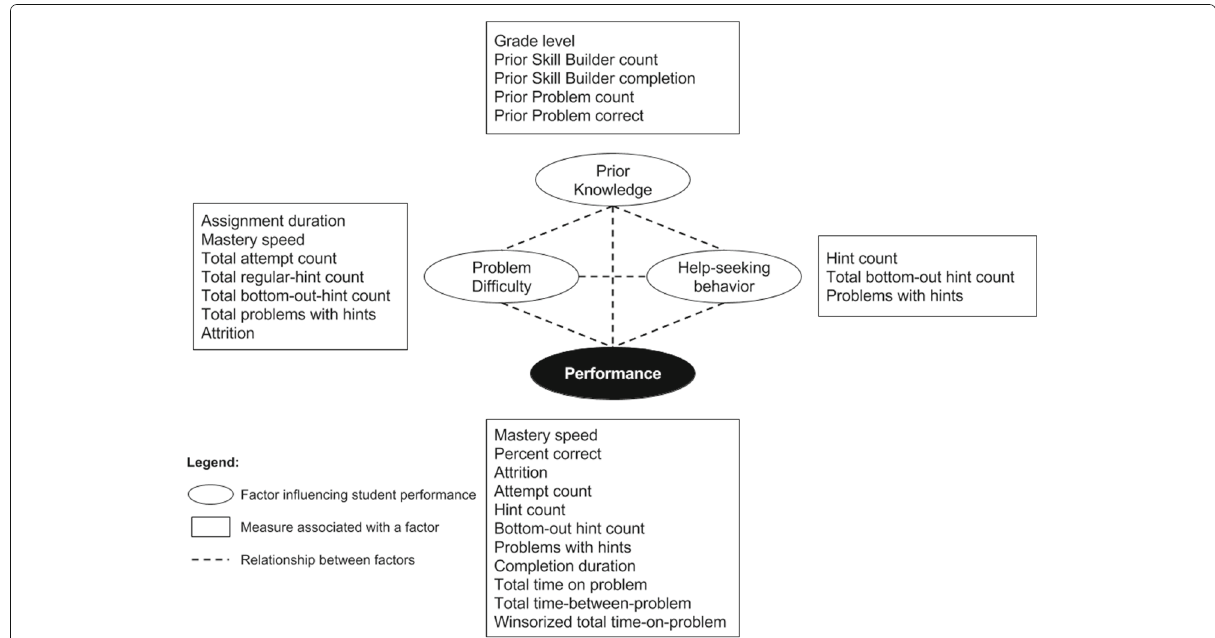
Fig. 4 Working model used to explain differences between sample